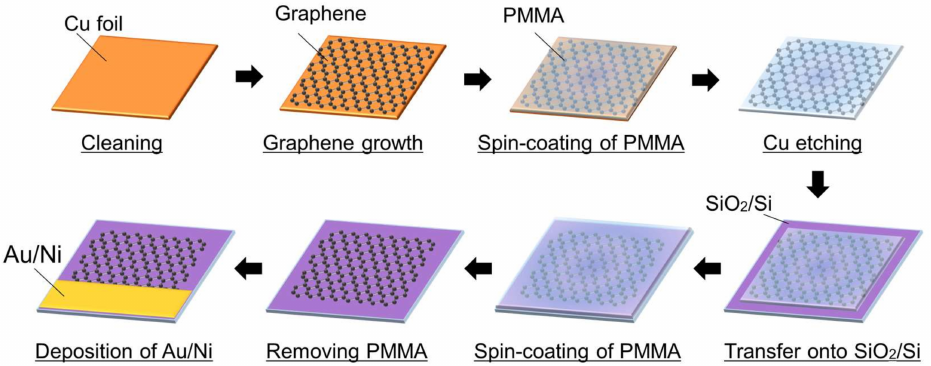
Figure 1. The fabrication process of the graphene